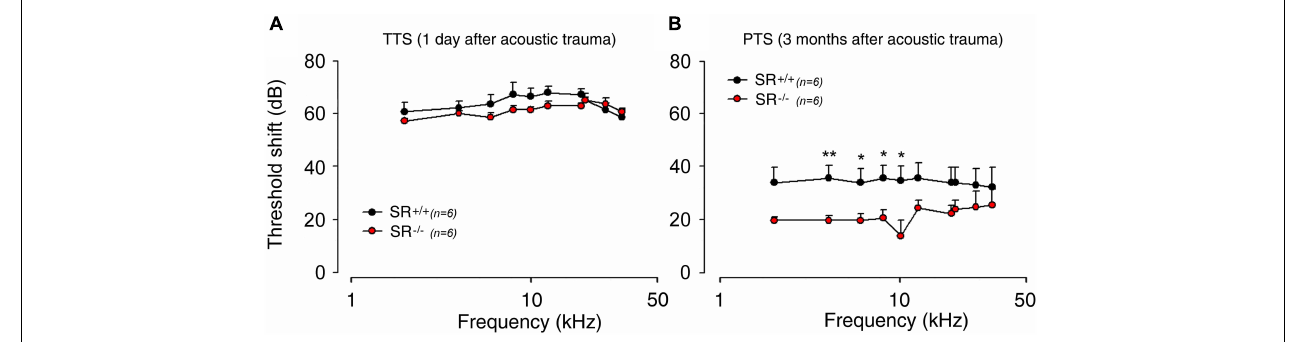
FIGURE 7 | Serine racemase deletion improved hearing recovery after noise exposure in adult mice. (A,B) ABR threshold shift in the SR + / + (black filled circle) and SR − / − (red filled circle) measured 1 day (A) and 3 months (B) after exposure to an 4–8 kHz octave-band noise at 100 dB for 2 h. Note that the threshold shift was similar 1 day after noise exposure in both strains. Interestingly, a better recovery of hearing ∼ 16.5 dB was observed in SR − / − mice 3 months after noise exposure. *( p < 0.05) and ** P <